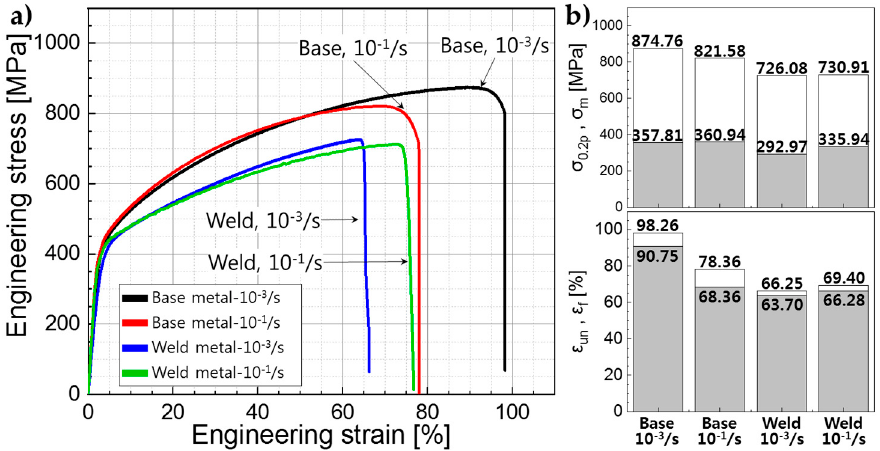
Figure 8. The results of uniaxial tensile test on the base and the weld zone. All specimens were deformed along the welding (rolling) direction: ( a ) engineering stress–strain curves (strain rate of 10 − 3 / s and 10 − 1 / s). ( b ) Diagrams showing summarized mechanical properties of tensile test specimens.